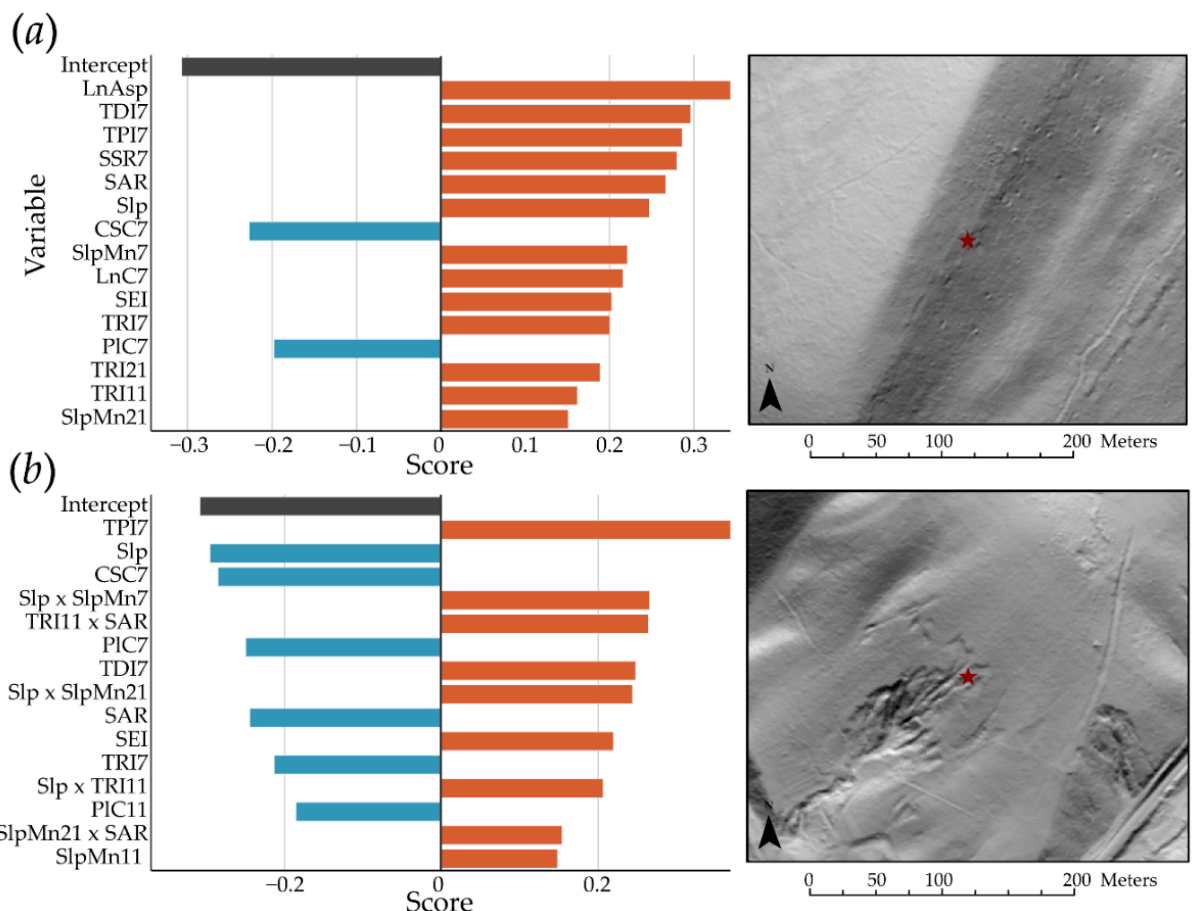
Figure 11. Variable contribution estimates or scores for two sites as an examples of local model explanations provided by EBM. Only the top 15 contributing variables are included in the charts. ( a ) Non-slope failure site incorrectly predicted as a failure; ( b ) slope failure site correctly predicted, but with low probability.